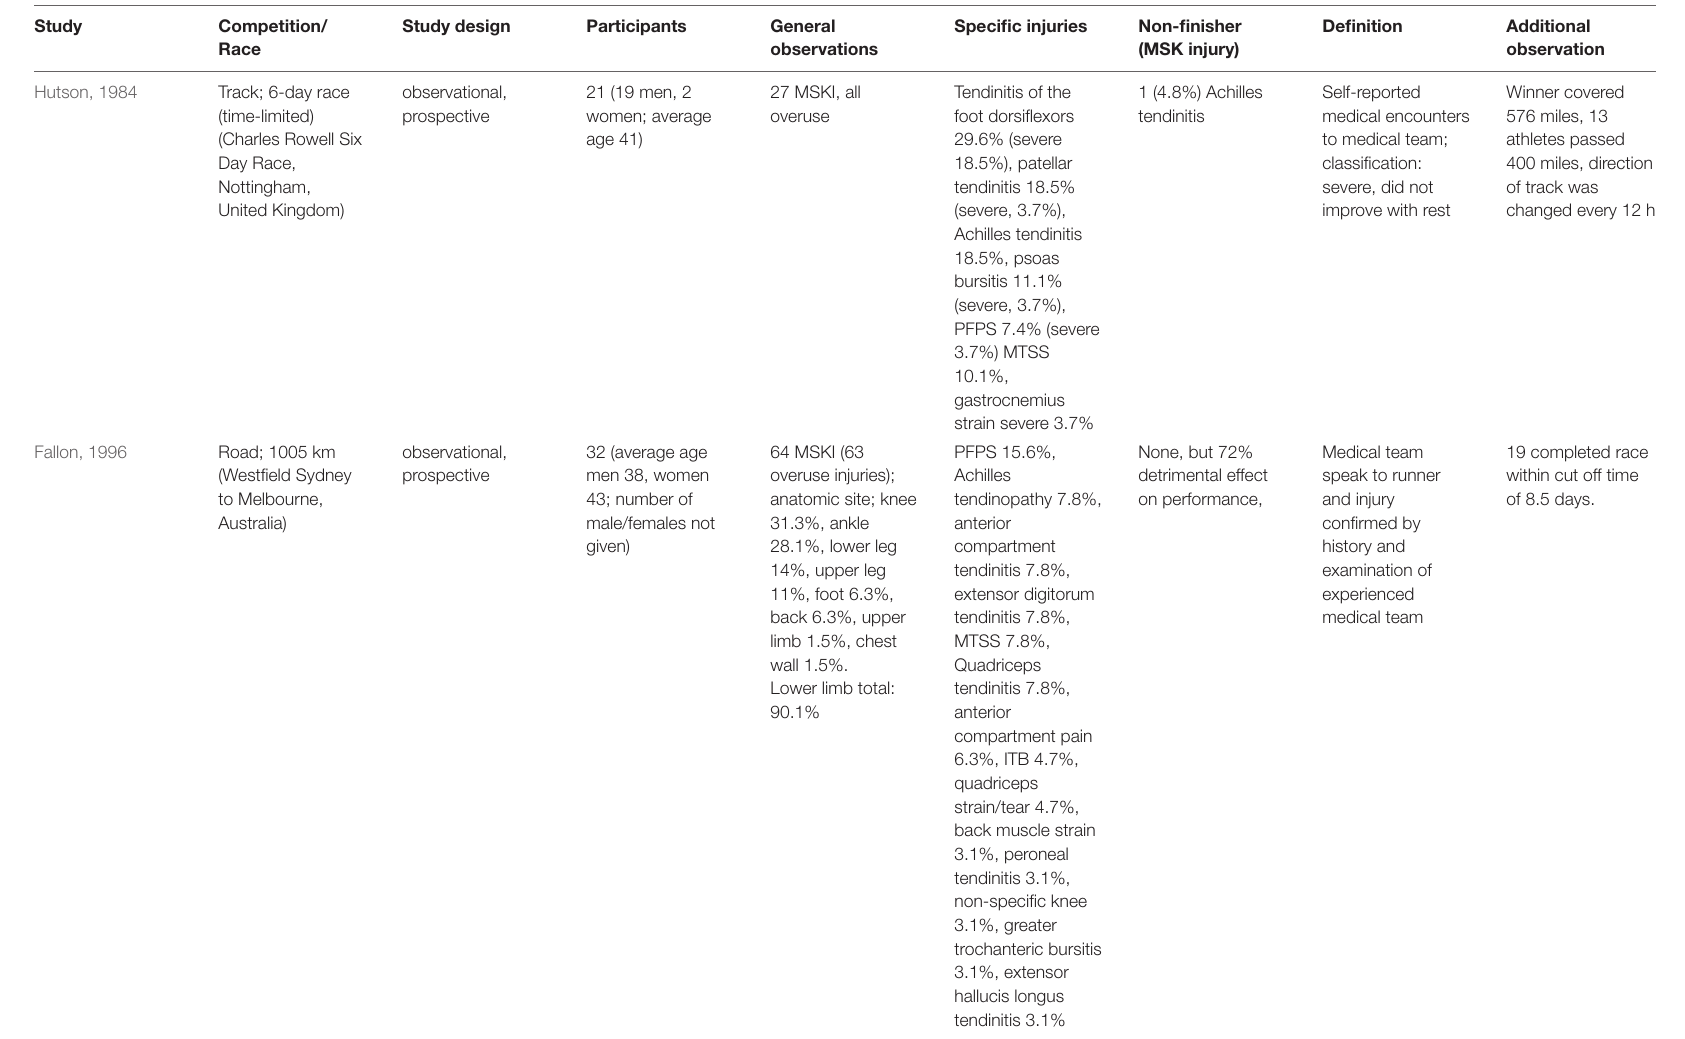
TABLE 1 | Studies investigating musculoskeletal injuries (MSKI) during